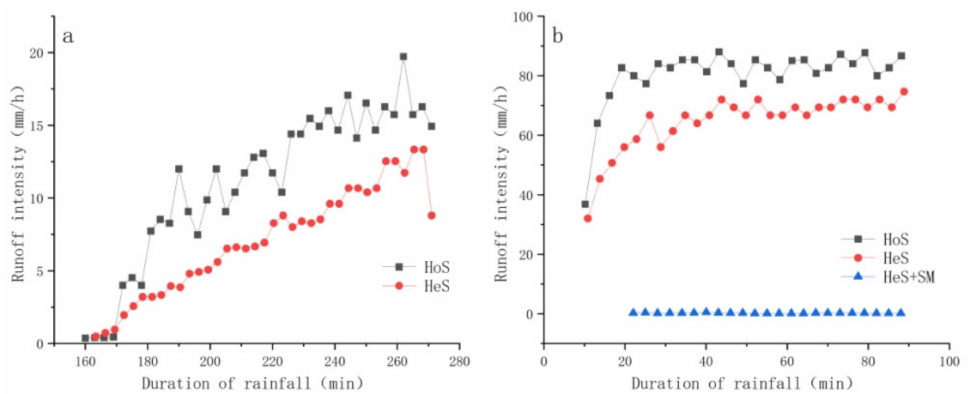
Figure 3. Surface runoff process under different rainfall patterns ( a ) Long duration-low intensity rain; ( b ) Short duration-high intensity rain. HoS, Homogeneous soil. HeS, Heterogeneous soil. HeS + SM, Heterogeneous soil + Straw mulch.